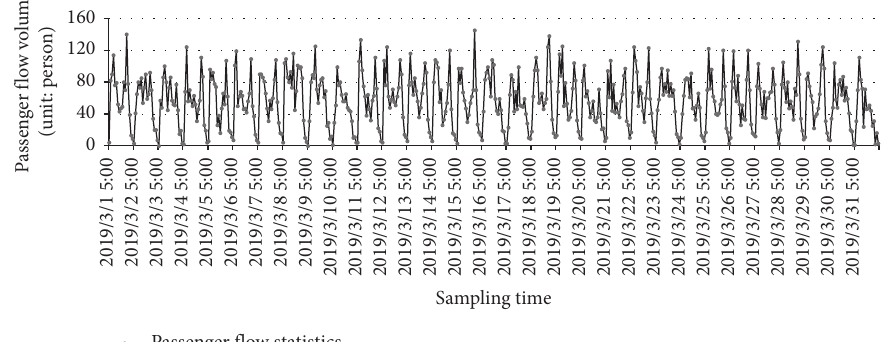
Figure 3: Passenger flow statistics within every 30 minutes of station 7 of line 28 in March.